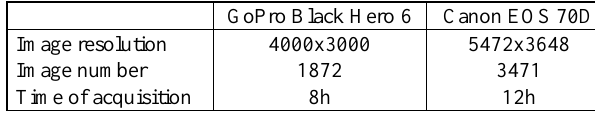
Table 1. Comparative table between GoPro Black Hero 6 and